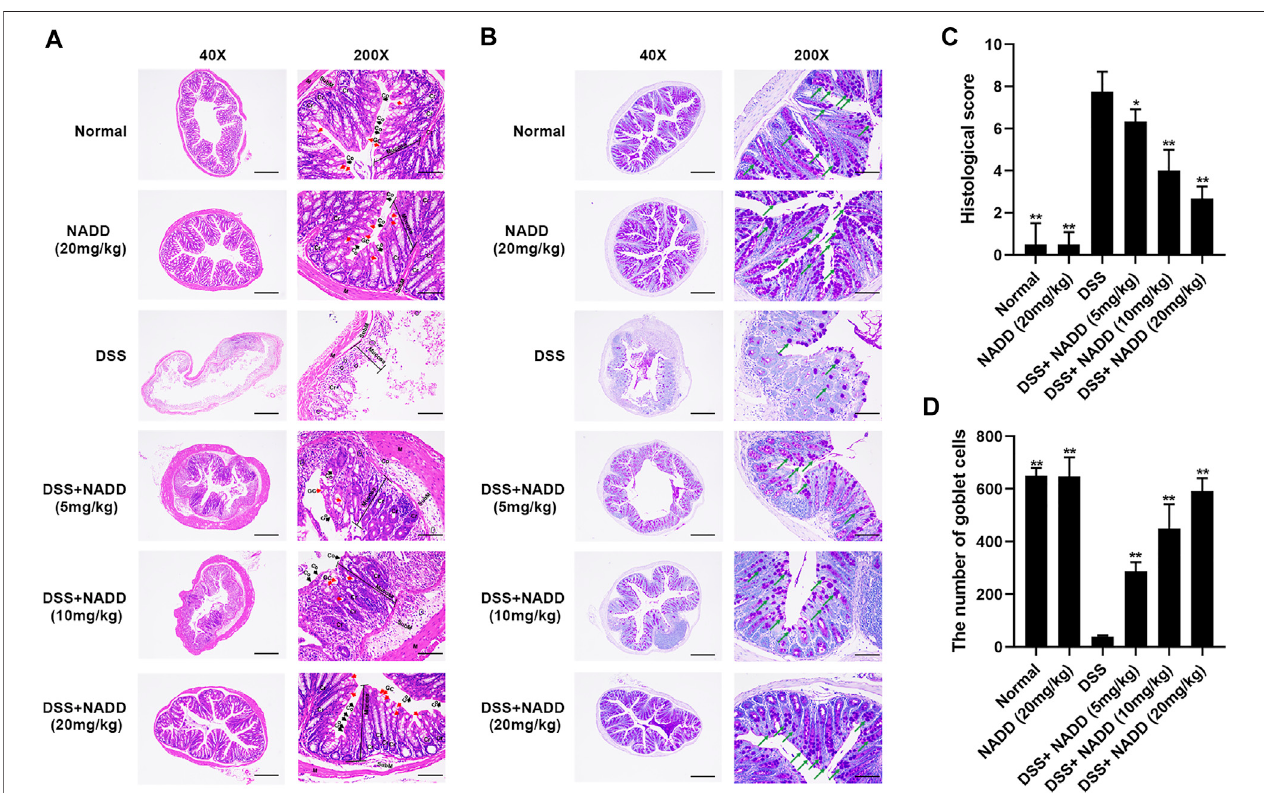
FIGURE2| HE and PASstaining. (A) Representativeimages ofHE stainingsections ofcolon;GC,goblet cells (redarrows);Cr, Crypts; Co,Columnar colonocytes (black arrows); SubM: Submucosa; Cells in the circle are Neutrophils. (B) Representative images of PAS staining; Amaranth granules are mucin glycoproteins (green arrows). (C) HistologicalscoresofcolontissueswithorwithoutDSSinductionandwithorwithoutadministrationofNADD. (D) Thenumberofgobletcellsofcolontissues with or without DSS induction and with or without administration of NADD. Differences were statistically signi fi cant when compared with the DSS group mice (* p < 0.05, **p <